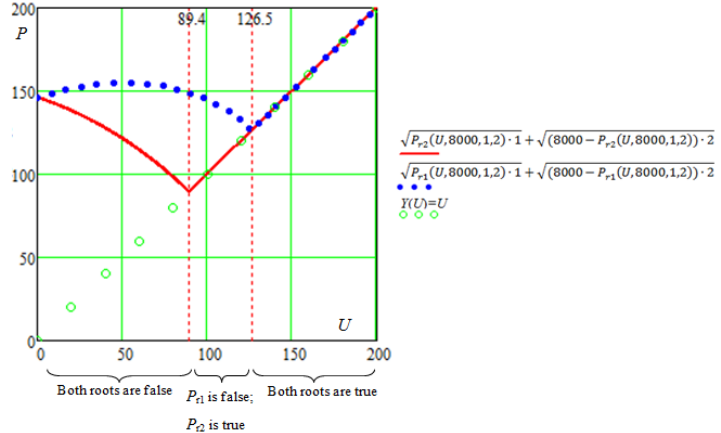
Figure 8. Determining the range of admissible values of the parameter for Equation (8).